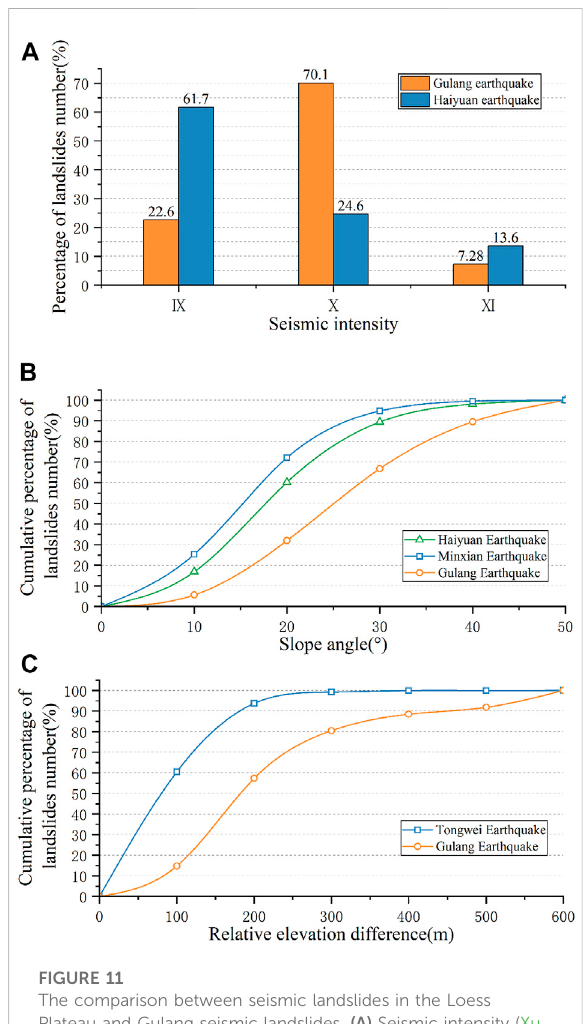
FIGURE 11 The comparison between seismic landslides in the Loess Plateau and Gulang seismic landslides. (A) Seismic intensity (Xu etal., 2018); (B) slopeangle (Xu et al., 2014; Xu et al.,2018); and (C) relative elevation difference (Xu et al., 2020c).